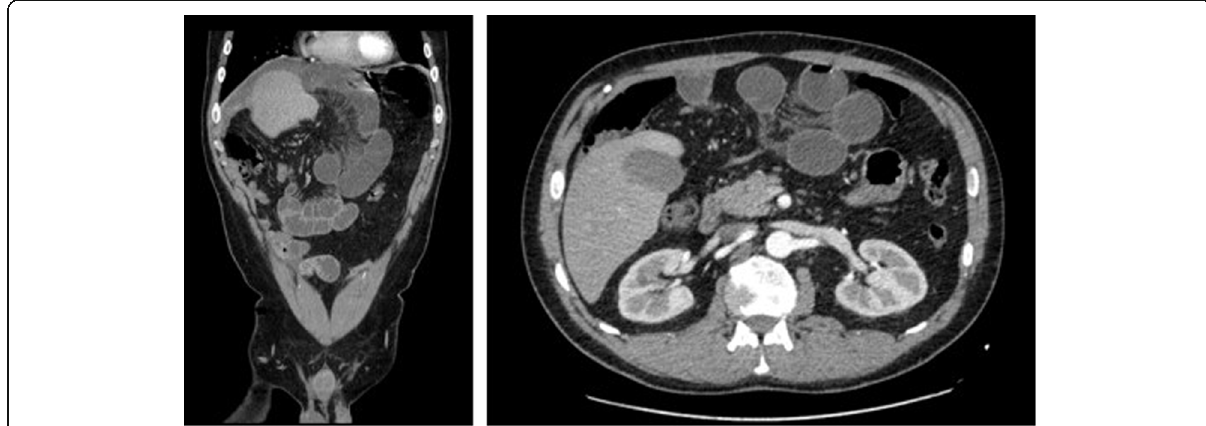
Fig. 3 Corona ( a ) and axial ( b ) abdominal CT images showing dilated small bowel loops with mesenteric congestion and fat